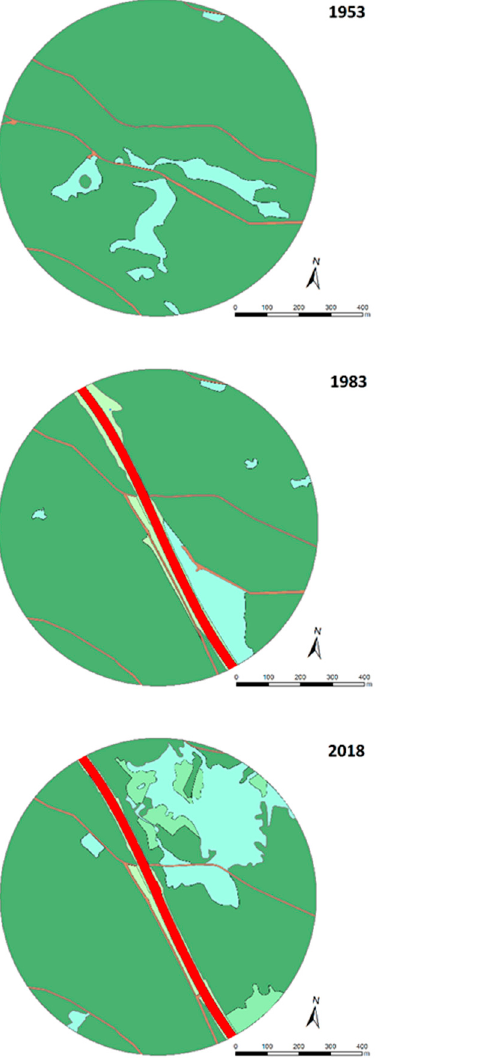
Figure 6. Land cover development at Site B.